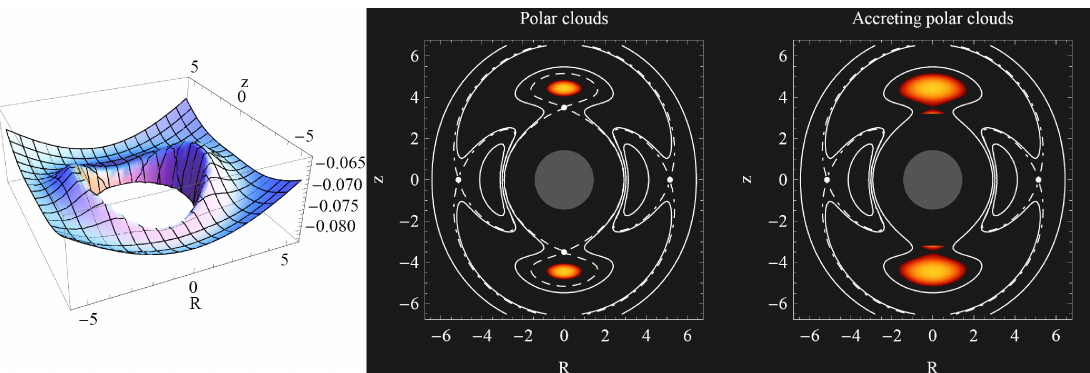
Figure 26. Typical behavior of the potential W for the charged fluid shown in terms of its poloidal equipotential contours—continuation of Figure 25.